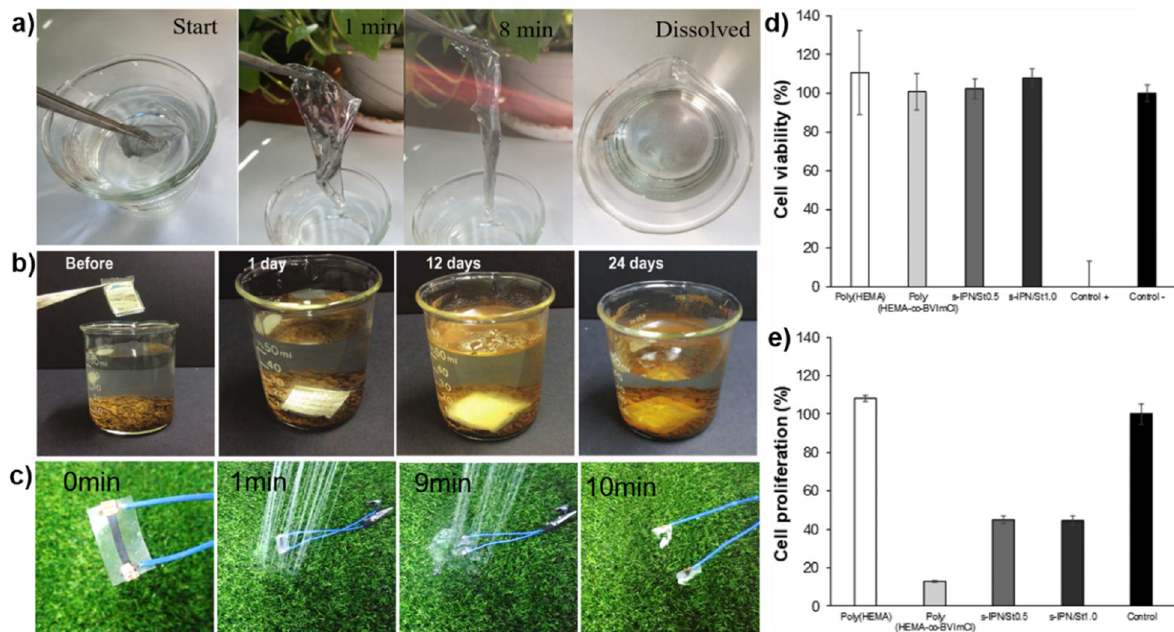
Fig. 10 Degradability and biocompatibility of starch-based FEs. a Dissolution behaviors of the starch-based conductive fi lm. Reproduced with permission 38 . Copyright 2018, American Chemical Society. b Biodegradability tests of the starch-based device in fi shbowl water. Reproduced with permission 33 . Copyright 2017, Wiley. c Degradation of the starch-based sensor under water fl ushing. Reproduced with permission 37 . Copyright 2020, American Chemical Society. d , e The cell viability and the cell proliferation data of the hydrogels tested against fi broblasts. Reproduced with permission 45 . Copyright 2019, American Chemical